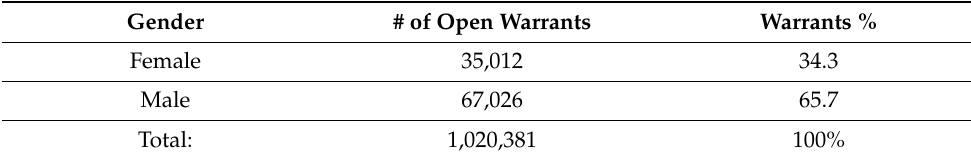
Table 7. Open Warrants by